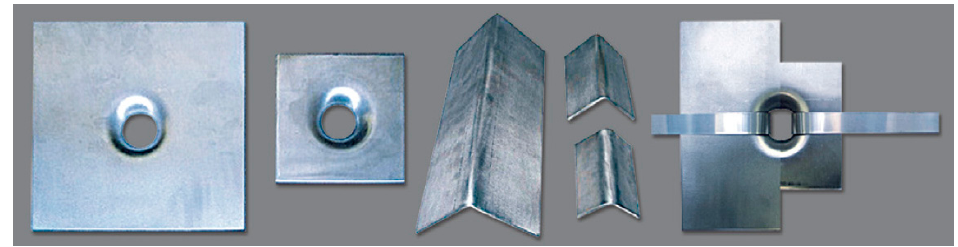
Figure 23. Protective elements of the CAM system [7].